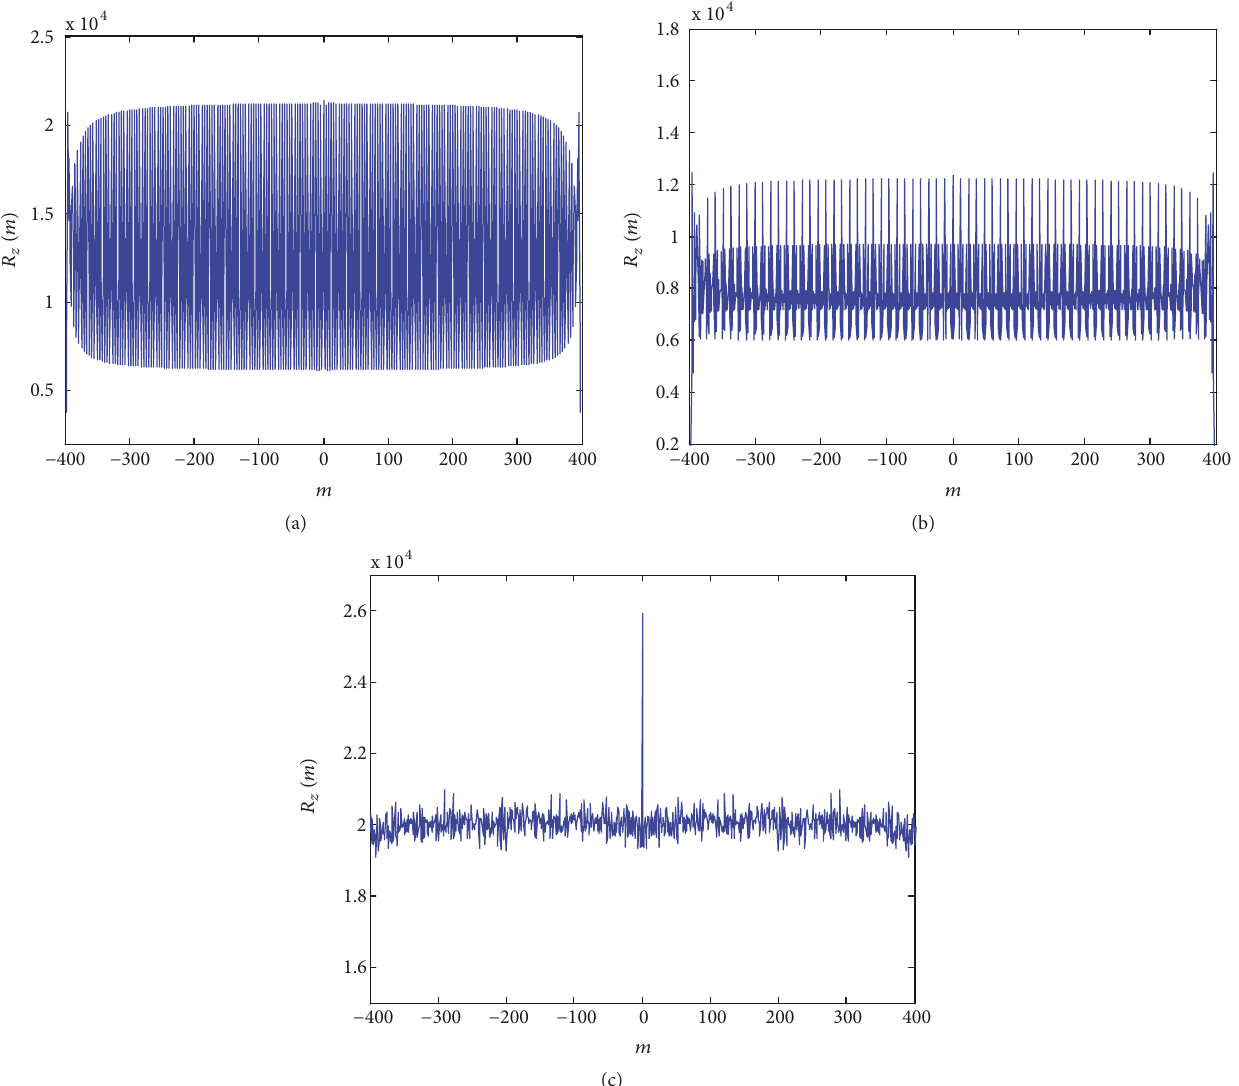
Figure 6: Autocorrelation test of chaotic sequences. (a) Logistic; (b) Tent; (c) improved method.